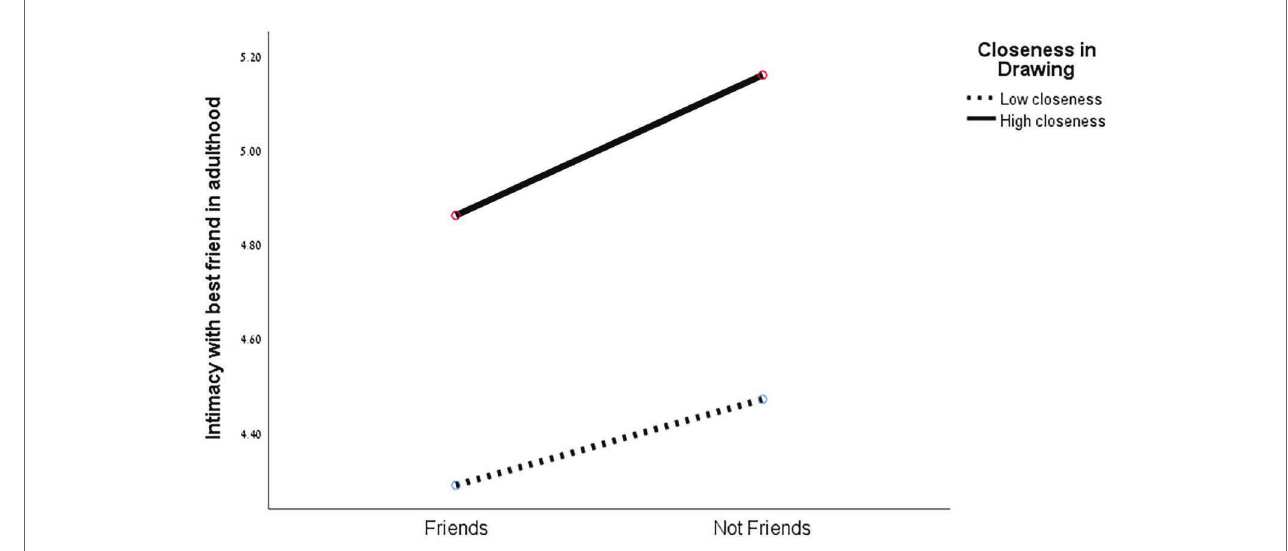
FIGURE 5 | Intimacy with best friend in adulthood and closeness in drawing (in adolescence).